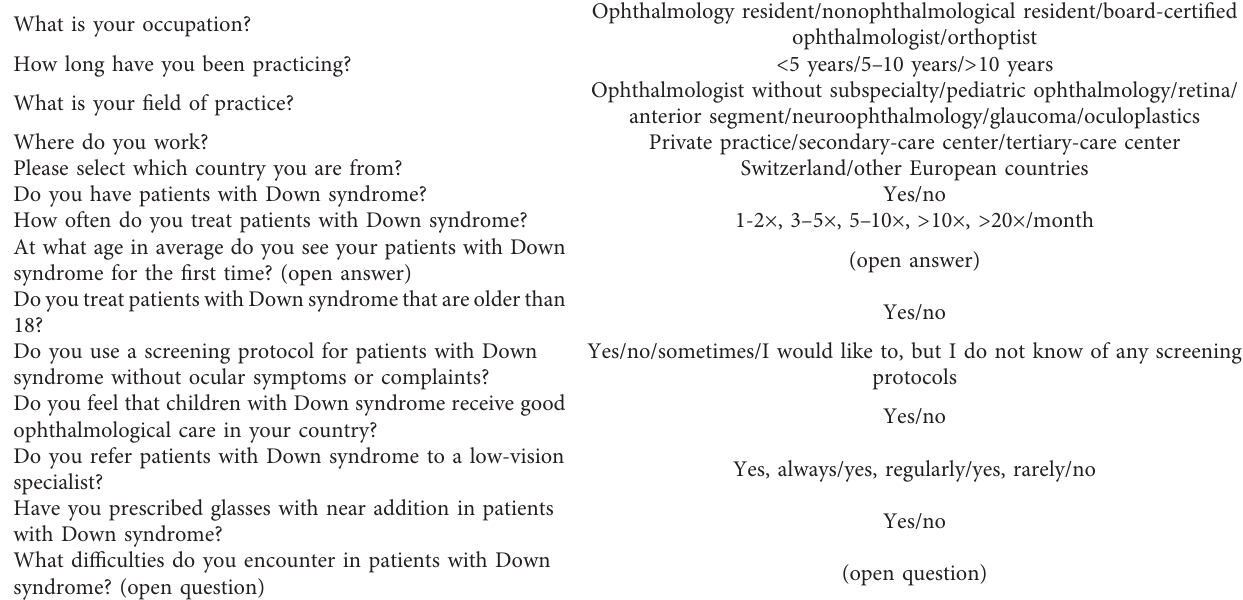
Table 3: Survey questions and response